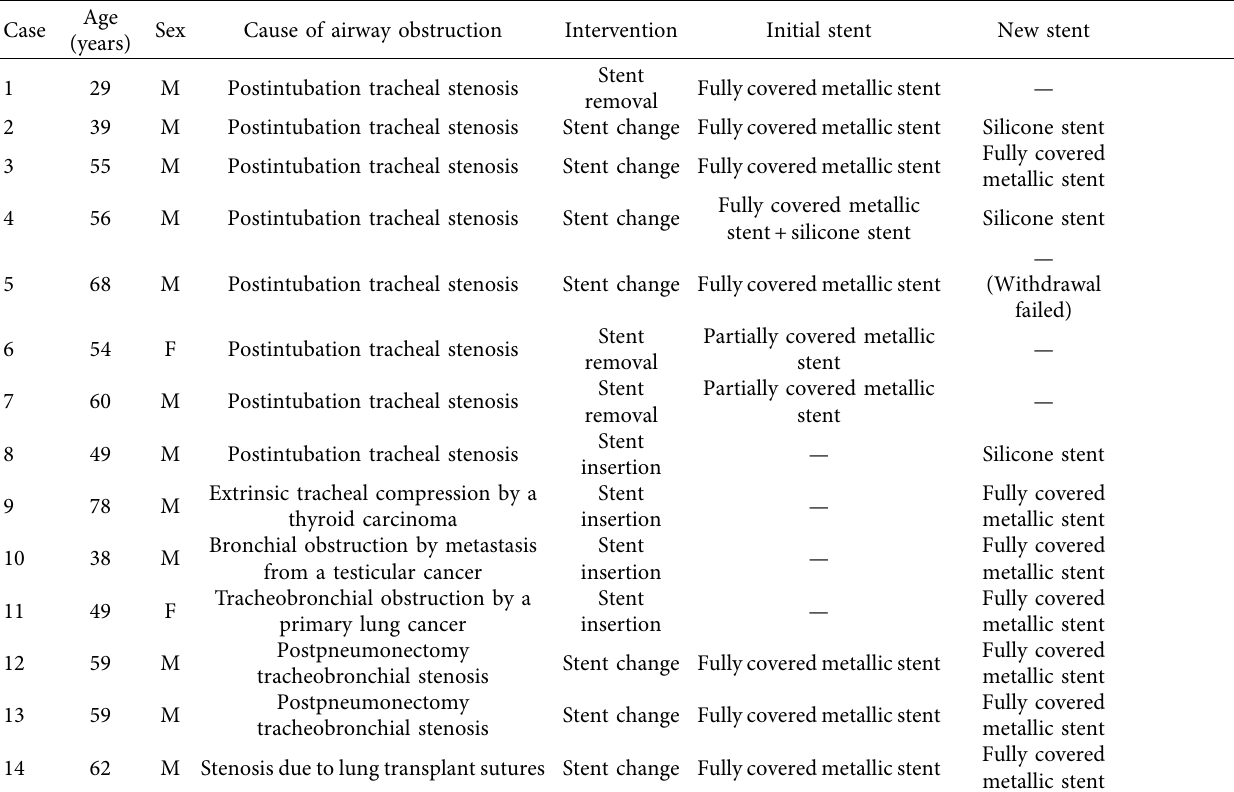
Table 1: Patient